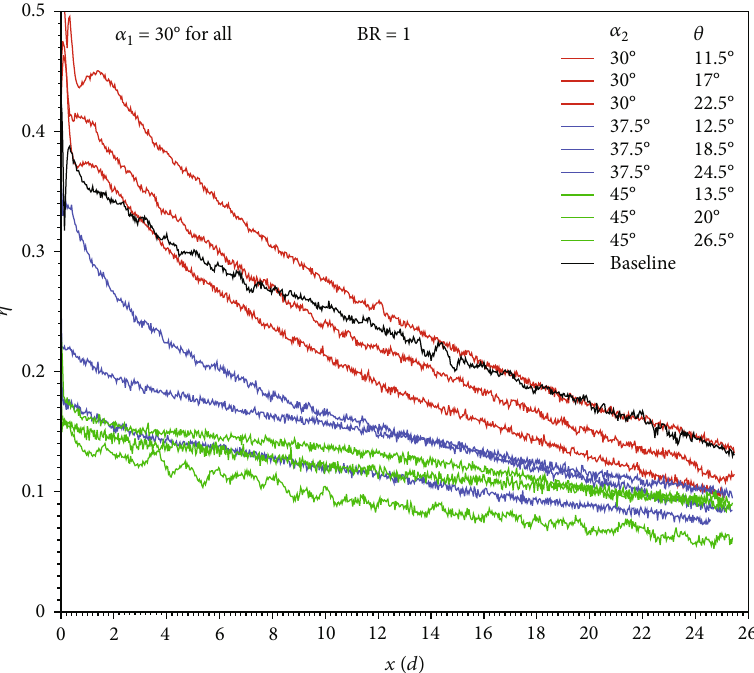
Figure 26: Comparison of streamwise (laterally averaged) fi lm e ff ectiveness variations for all geometries at BR = 1 .